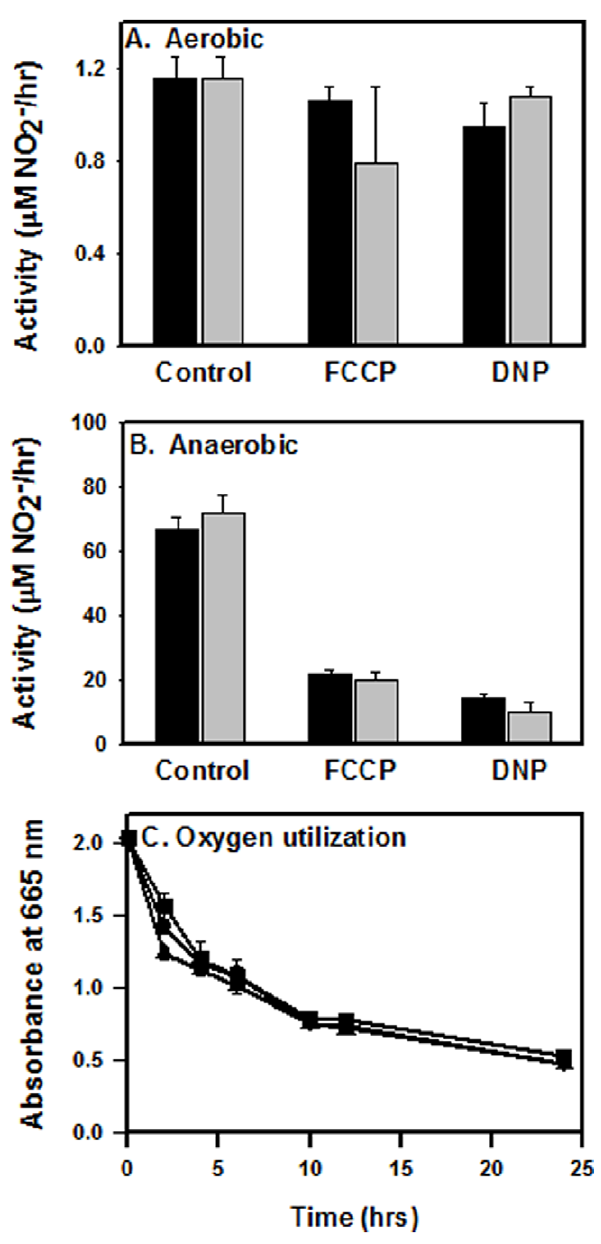
Figure 1. Effect of uncouplers on nitrite production. Cultures were grown either (A) aerobically or (B) to NRP-1 in the Wayne model. Each culture was then adjusted to a similar cell density. Nitrate was added along with uncouplers where indicated. Nitrite concentrations were measured at 2.5 hrs intervals. Black bars are without nitrite, while grey bars are from experiments following 2 hrs of preincubation with 50 m M NO 2 2 . (C) M. tuberculosis was grown to mid-exponential phase and then divided for further incubation in full sealed tube with 0.0003% methylene blue (circles) and either DNP (squares) or FCCP (triangles). Standard deviation is indicated.